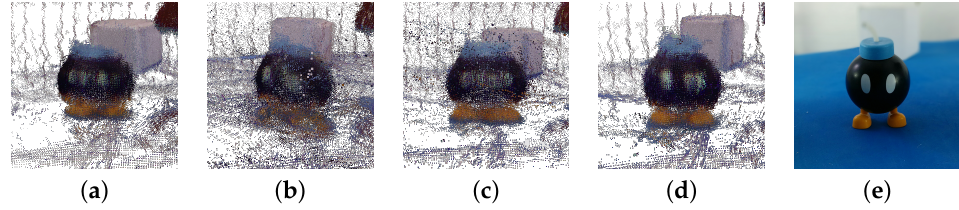
Figure 22. Frontal view of the reconstruction of the Object 2 obtained using different calibration methods with Microsoft Kinect v1. ( a ) Original; ( b ) Burrus; ( c ) Bouguet; ( d ) Herrera; ( e )